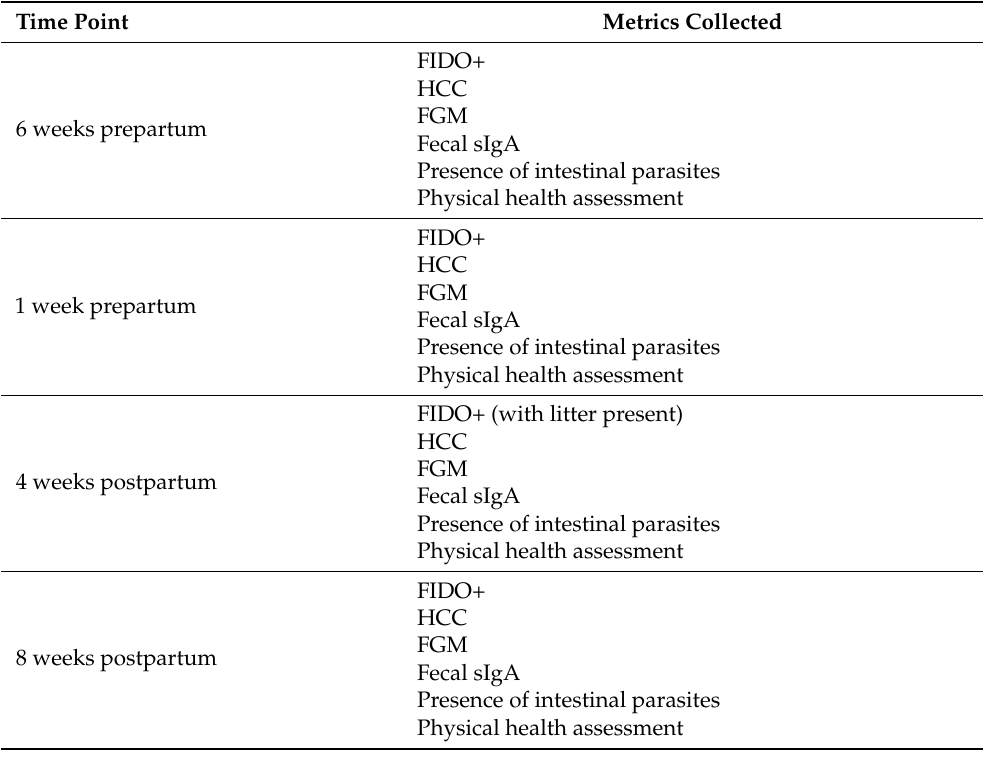
Table 1. Data collection time points and metrics